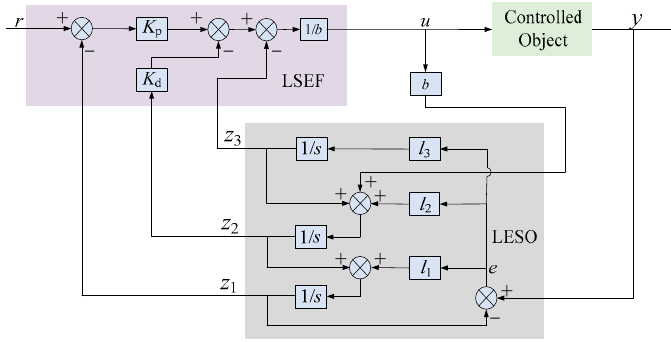
Figure 5. Structure of second-order linear active disturbance rejection control (LADRC).